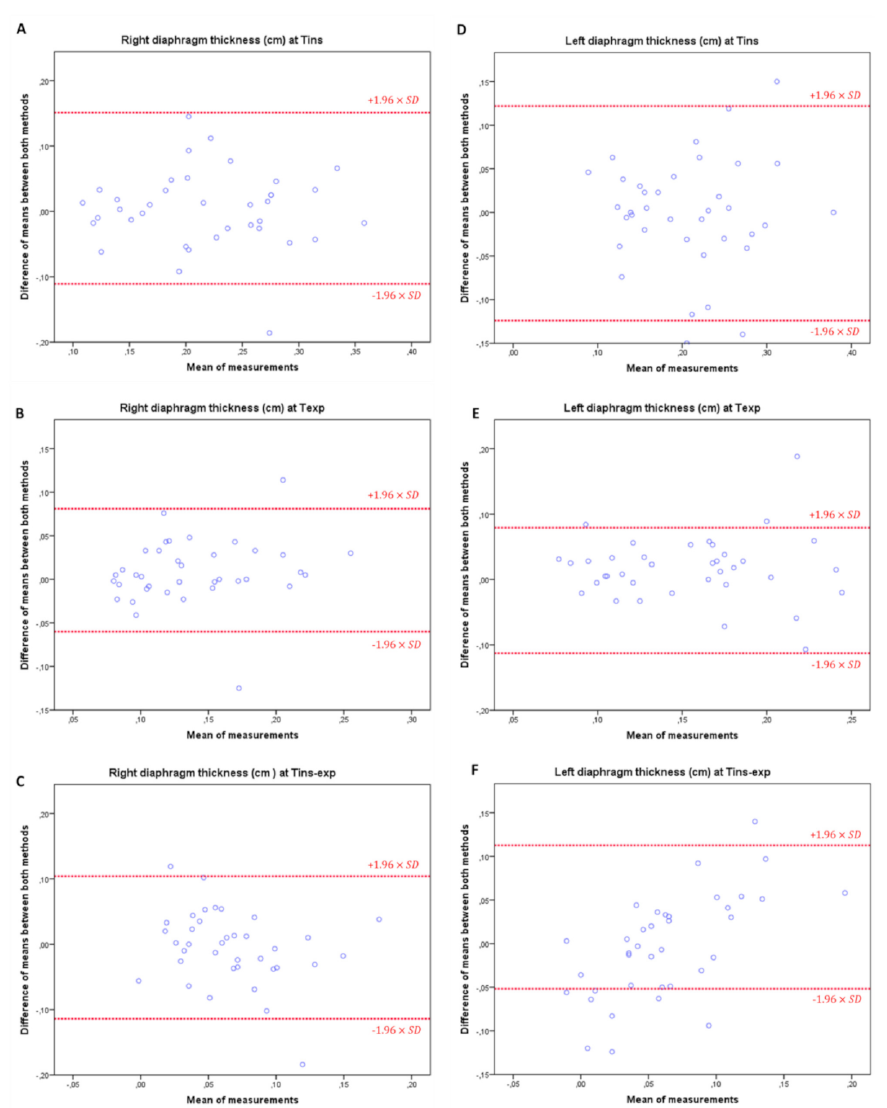
Figure 3. Bland-Altman plots agreement between both manual and specific orthosis device measure- ment methods for the right and left diaphragm thickness at T ins , T exp and T ins-exp , completed with the upper and lower limits of agreement (LoA). ( A ) Right diaphragm thickness at maximum inspiration (T ins ) during relaxed breathing. ( B ) Right diaphragm thickness at maximum expiration (T exp ) during relaxed breathing. ( C ) Right diaphragm thickness difference (T insp-exp ) during relaxed breathing. ( D ) Left diaphragm thickness at maximum inspiration (T ins ) during relaxed breathing. ( E ) Left diaphragm thickness at maximum expiration (T exp ) during relaxed breathing. ( F ) Left diaphragm thickness difference (T insp-exp ) during relaxed